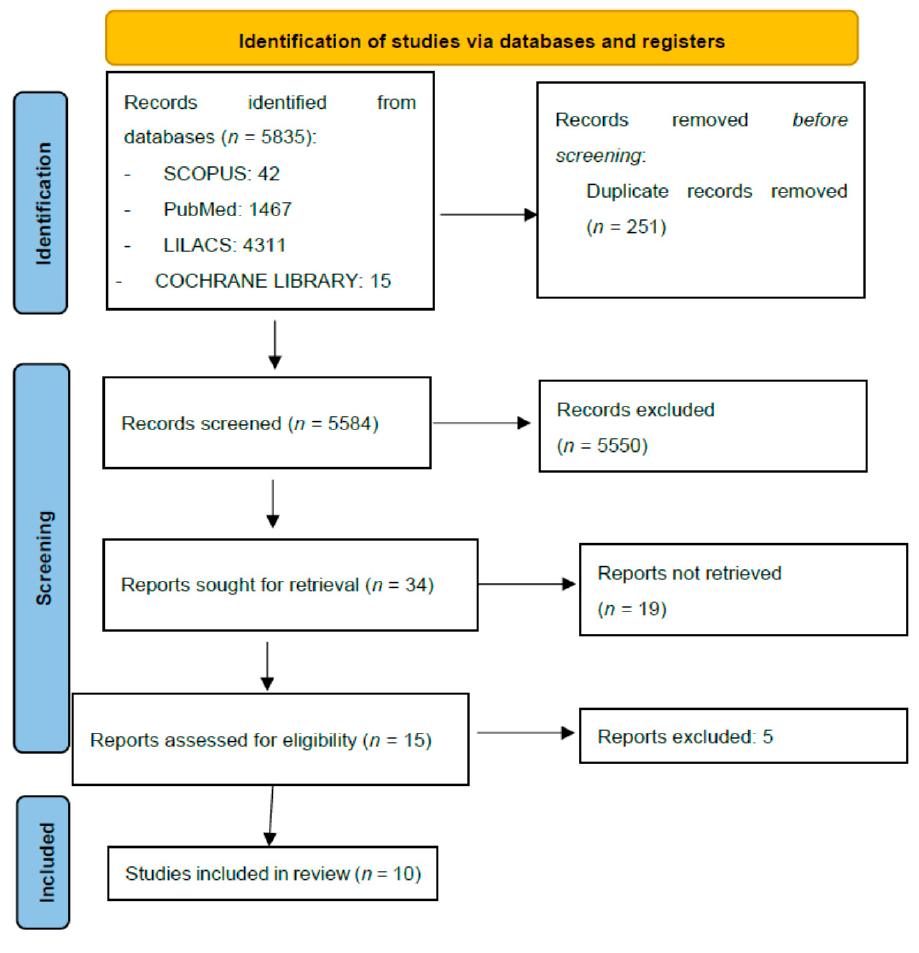
Figure 1. PRISMA flow chart.